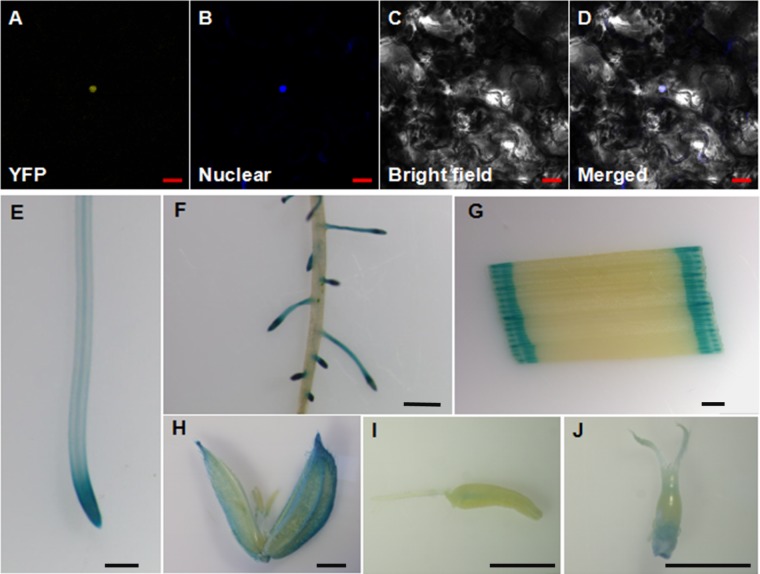
Subcellular localization and expression pattern of OsWRKY28. (A–D) Subcellular localization of OsWRKY28. Confocal image of tobacco (Nicotiana benthamiana) epidermal cells expressing the OsWRKY28:eYFP fusion protein (A). (B) Confocal images of epidermal cells stained by a nuclear specific dye 4,6-diamidino-2-phenylindole (DAPI). (C) Bright-field images. (D) The merged image of (A–C). Bar = 20 μm. (E–J) Expression pattern of OsWRKY28 was revealed by GUS-staining. Primary root (E), lateral root, (F), leaf (G), caryopsis at the flower development stage (H), stamen (I), stigma and ovary (J). Four independent GUS lines were observed, and the same results were obtained. Bar = 1 mm.